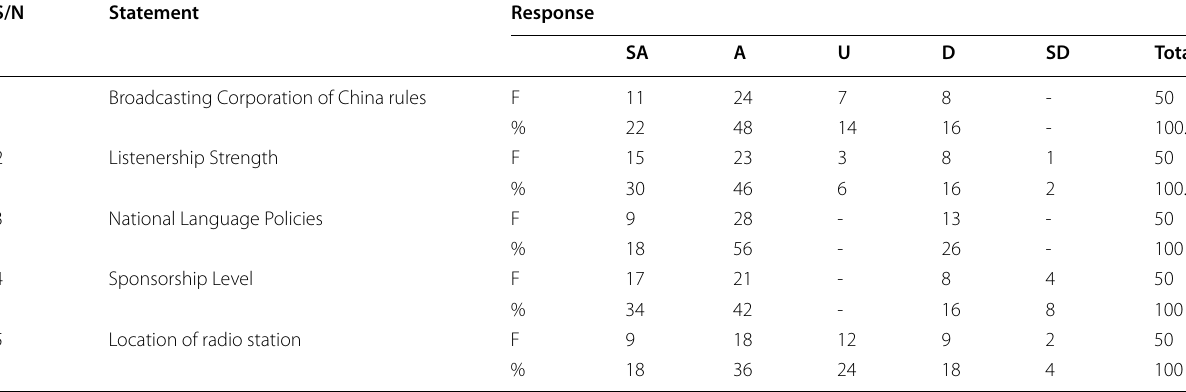
Table 12 Factors that Influence the democratic distribution of languages in the radio stations in Hunan (Staff response)